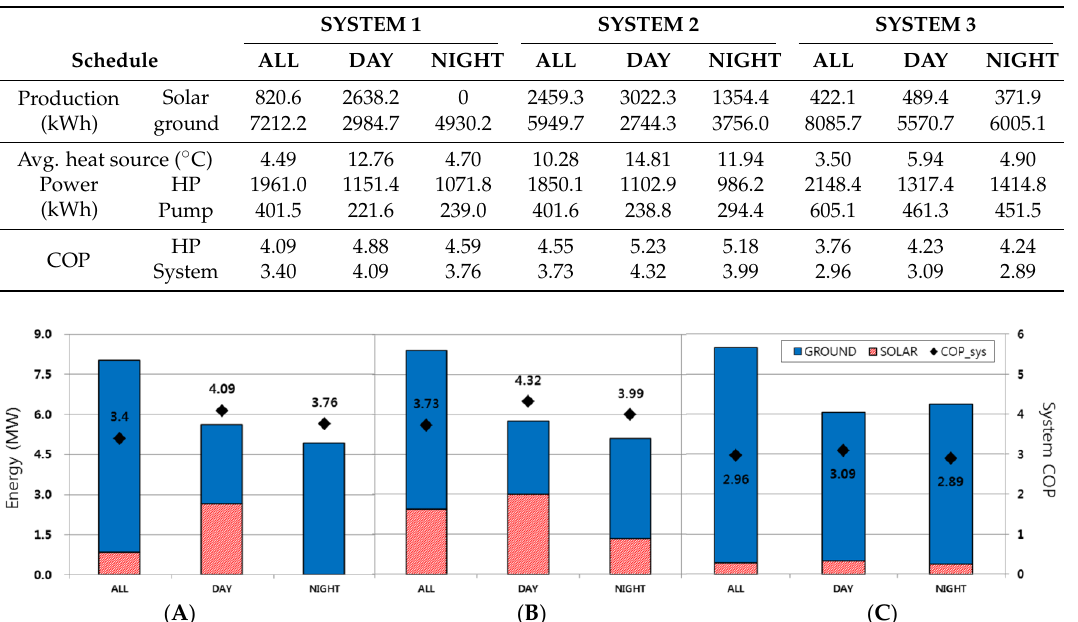
Table 2. Simulation results.